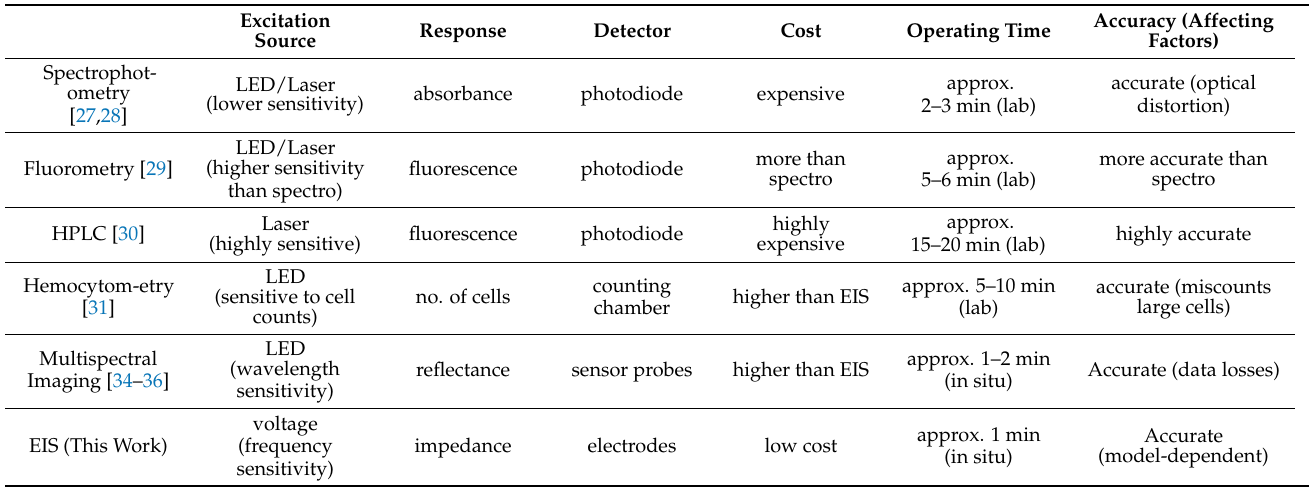
Table 2. Comparative study of EIS with other non-destructive methods for the estimation of Chlorophyll-a in algae